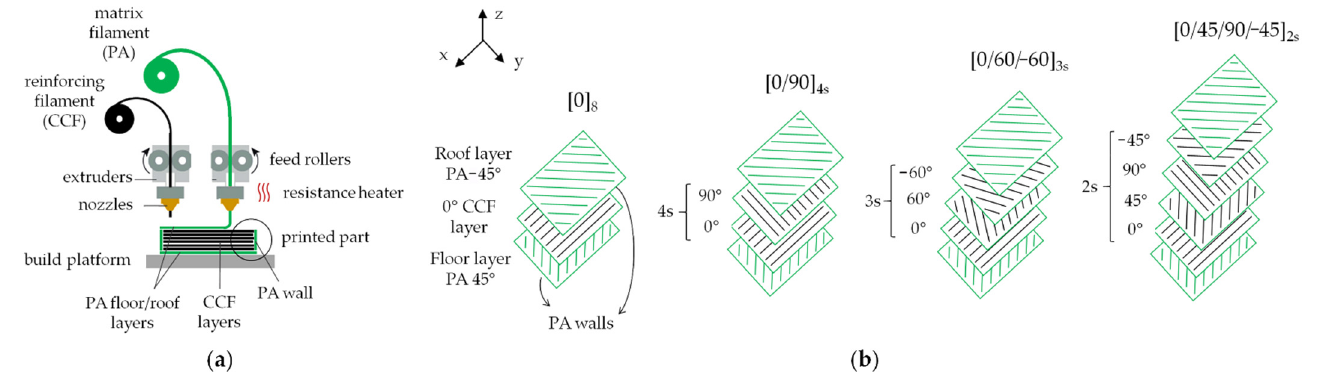
Figure 1. ( a ) Schematic representation of MarkForged ® FFF printing process; ( b ) internal structure of the CCF/PA composites comprising PA roof/top layers, CCF reinforced intermediate layers showing fibers infill with different orientations (0 ◦ , 90 ◦ , 45 ◦ , 60 ◦ ) according to the layup adopted and a PA contour for each